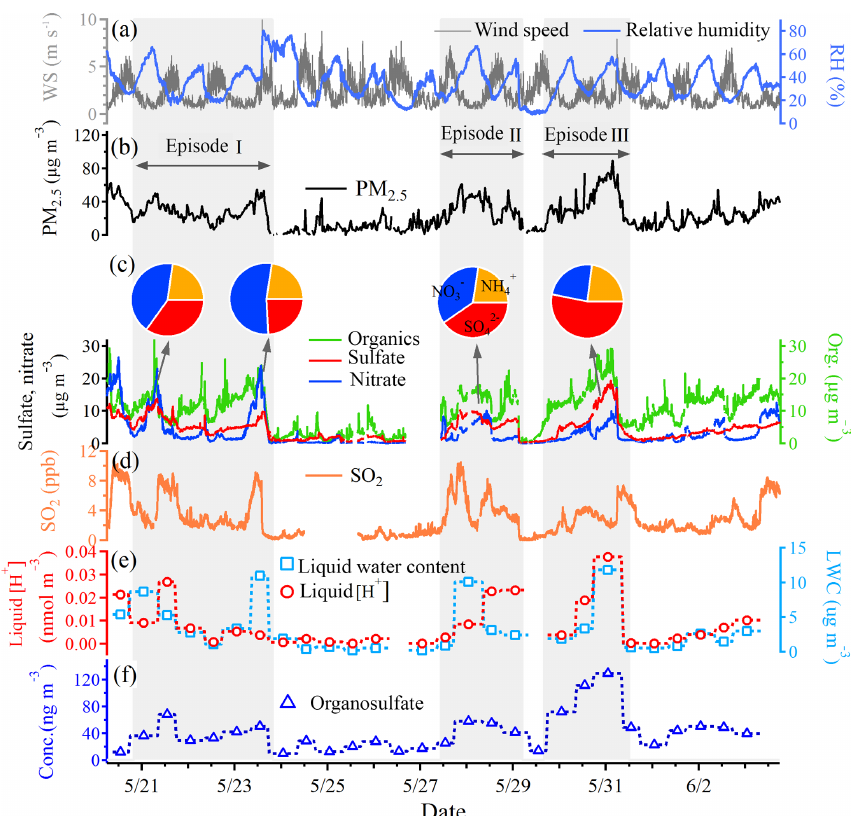
Figure 3. Time series of (a) wind speed (WS) and relative humidity (RH), (b) PM 2 . 5 , (c) mass concentrations of organics, sulfate, nitrate, and composition of secondary inorganic aerosols during pollution episodes, (d) SO 2 , (e) liquid water content (LWC) and aqueous-phase [H + ], and (f) the total concentrations of OSs quantified by HPLC–MS. The pollution episodes are marked by gray